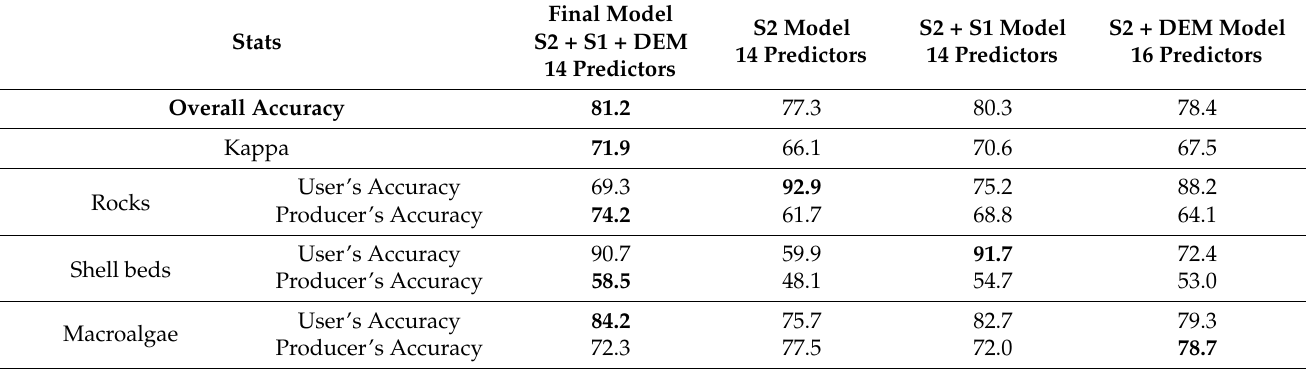
Table 6. Comparison of model performance between the model associating Sentinel-1, Sentinel-2, and DEM and three alternative models: using Sentinel-2 alone (S2 model); model using Sentinel-2 and Sentinel-1 (S2 + S1 model); and a model including Sentinel-2 and the digital elevation model. All alternative models were computed using the same workflow applied to obtain the best model. Performance statistics were calculated from independent validation with the training dataset and